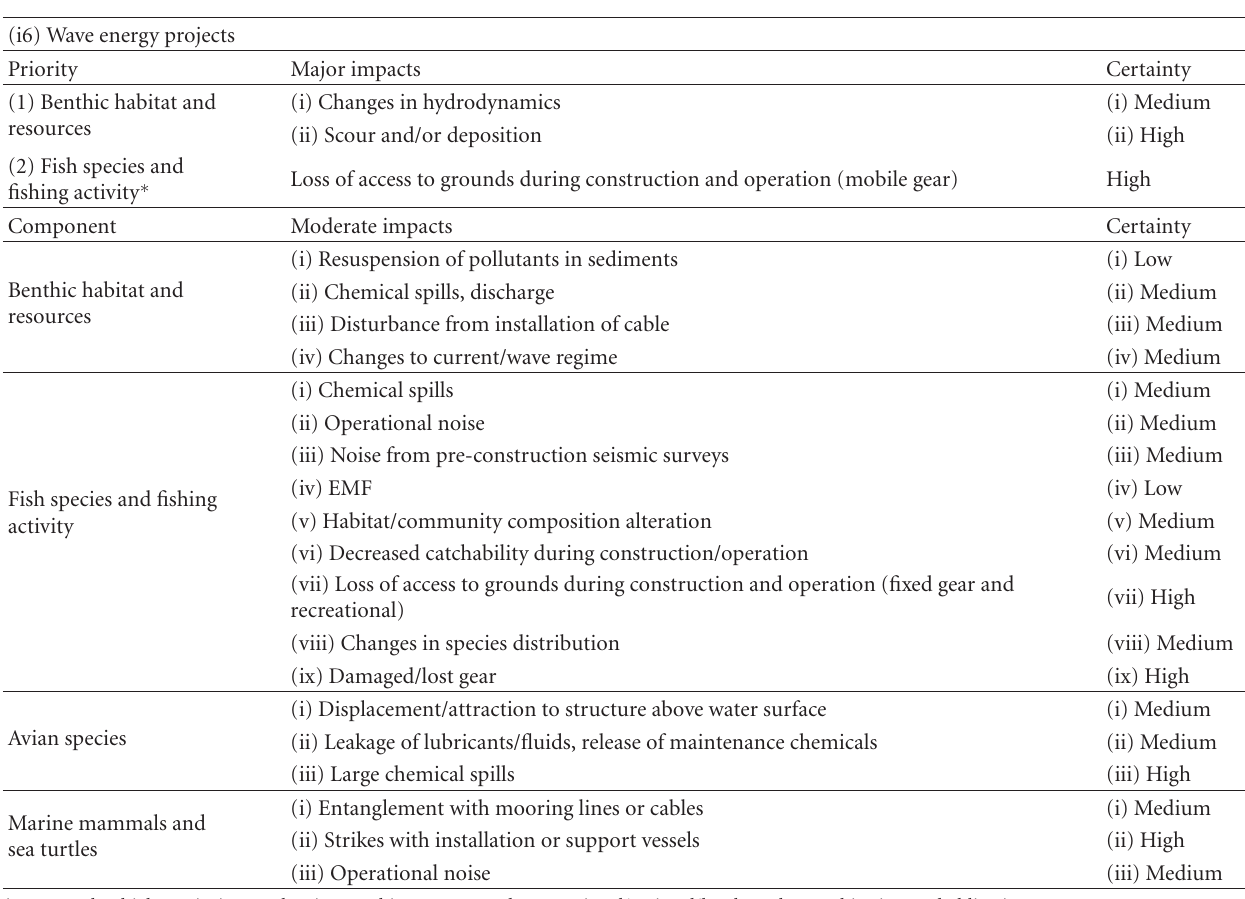
Table 8: A description of the potential impacts resulting from projects harnessing wave energy. See text, Section 3.3, for a narrative summary of this development scenario. Ecosystem components are ranked by their proportion of the major impacts. Moderate impacts are listed in the order they appear in the renewable energy impact